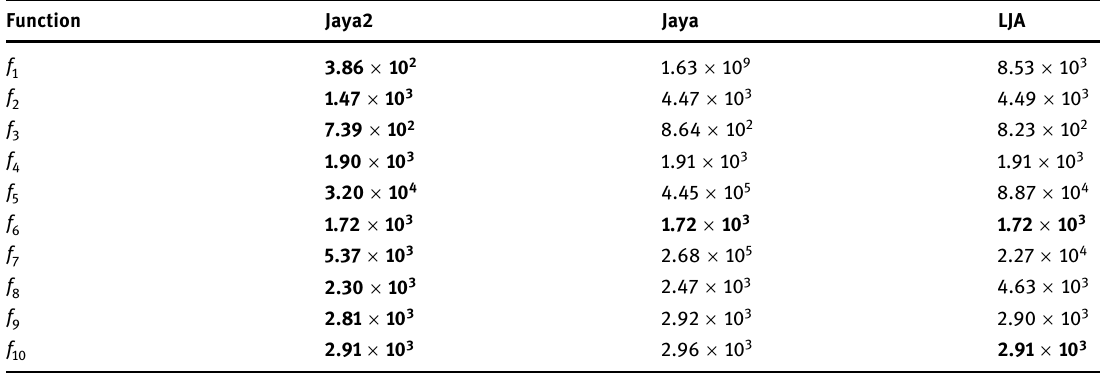
Table A1: The CEC 2020 ( = D 20 ) median function values achieved by Jaya2, Jaya, and LJA over 30 runs and 200,000 function evaluations Function Jaya2